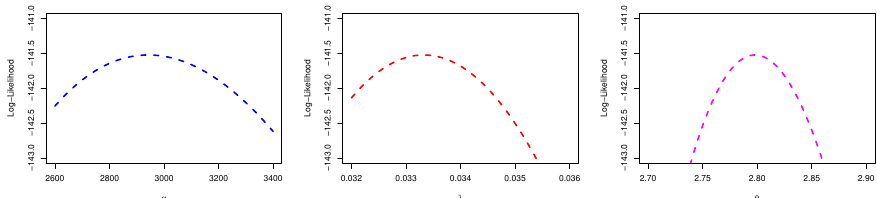
Figure 18. Plots of the profile-log likelihood functions of the fitted ECSGHL model for real data